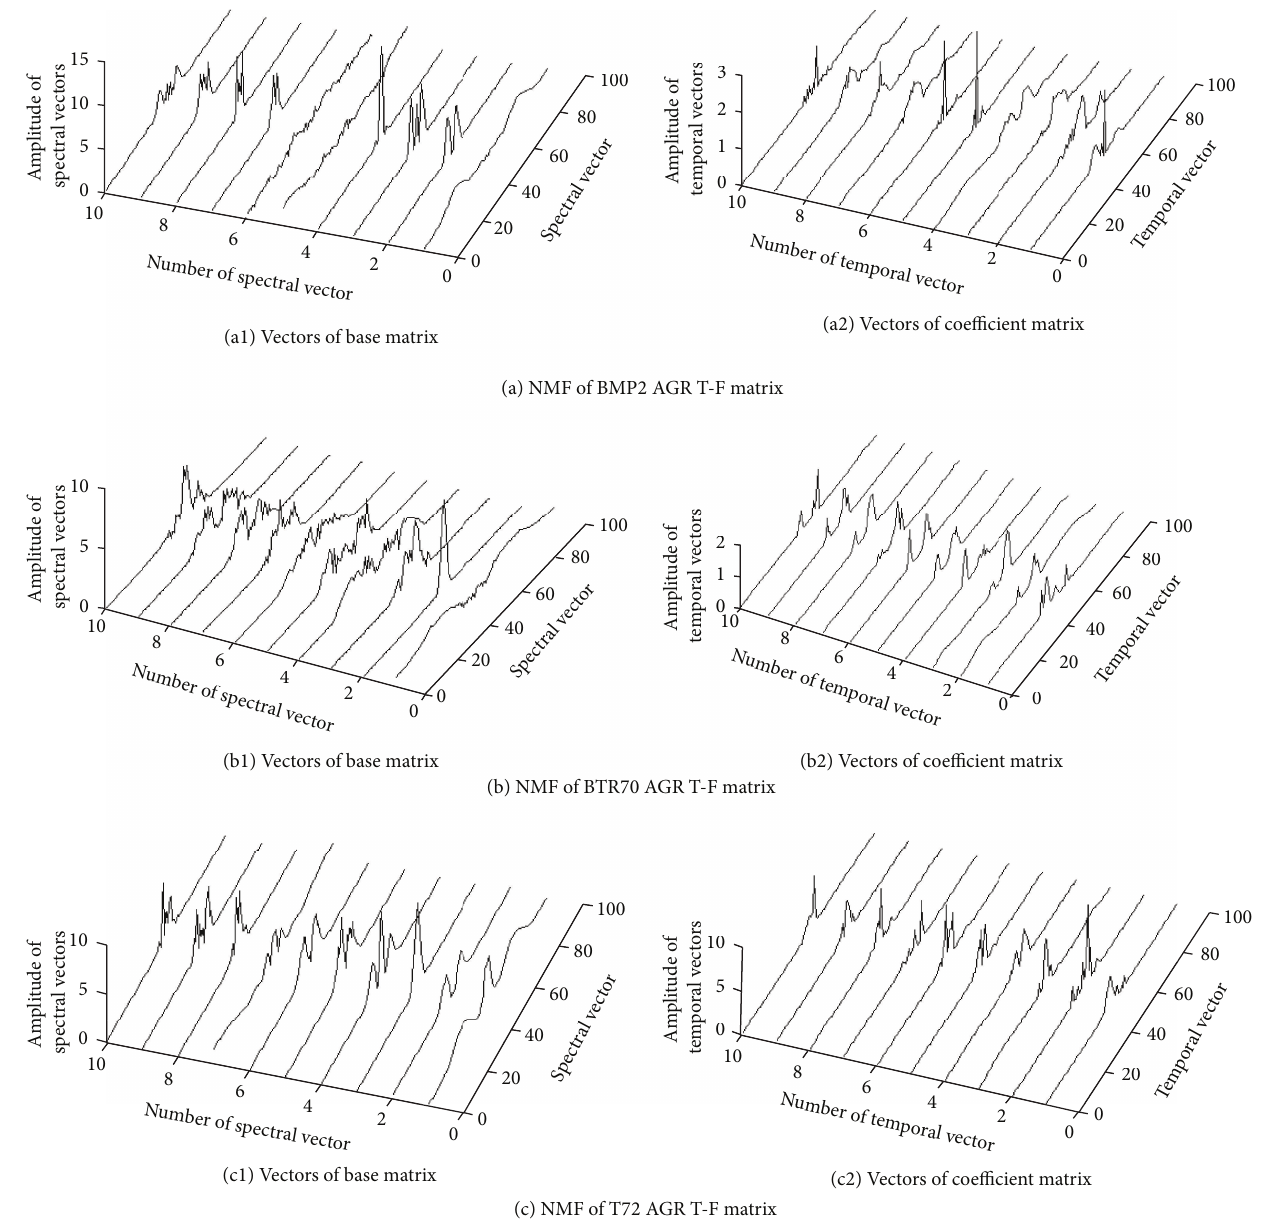
Figure 3: NMF of three targets AGR